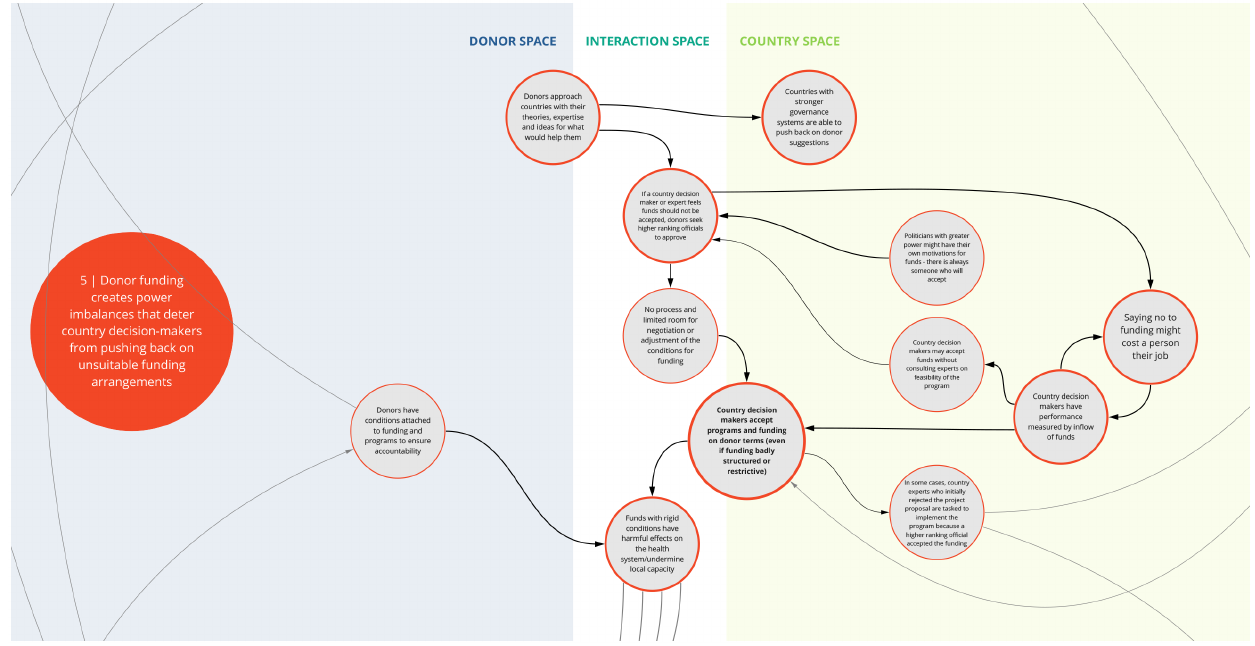
Figure 6. Syndrome 5: Donor funding creates power imbalances that deter country decision-makers from pushing back on unsuitable funding